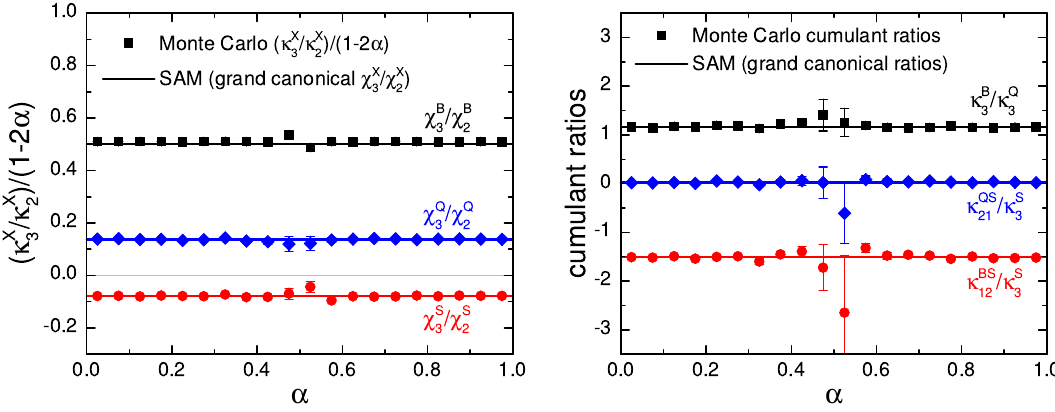
Figure 2 . Dependence of combinations of third and second order cumulants of conserved charges on the acceptance fraction (cid:11) , as calculated in the hadron resonance gas model using canonical ensemble Monte Carlo sampler (symbols) and analytically in the framework of the subensemble acceptance method (lines). The Monte Carlo sample is the same as in (cid:12)gure 1. Left panel: Skewness cumulant ratios (cid:20) 3 =(cid:20) 2 of net-baryon (black), net-charge (blue), and net-strangeness (red) numbers scaled by the global charge conservation correction factor (1 (cid:0) 2 (cid:11) ). Right panel: Ratio of third order conserved charge cumulant ratios (cid:20) B =(cid:20) Q (black), (cid:20) QS =(cid:20) S (blue), and (cid:20) BS =(cid:20) S (red). Monte Carlo 3 3 12 3 3 21 third order cumulants in HRG, diagonal (left) and o(cid:11)-diagonal